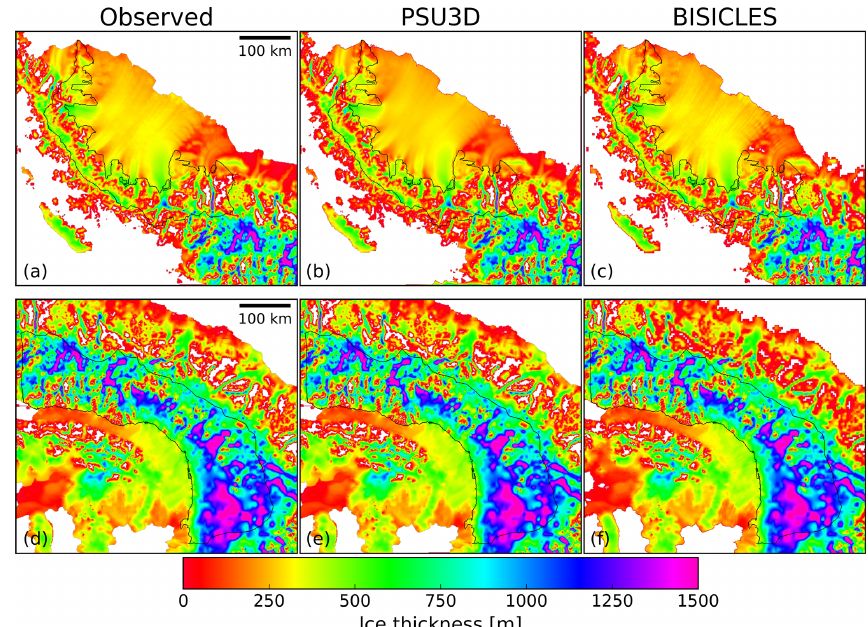
Figure A4. Observed ice thickness distribution (BEDMAP2; Fretwell et al., 2013) for Larsen C (a) and George VI (d) embayments and modelled ice thickness distribution after spin-up for Larsen C (b, c) and George VI (e, f) embayments. Black lines denote modelled drainage